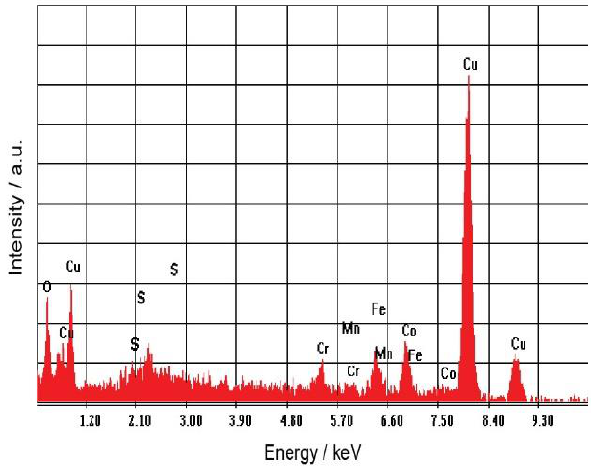
Figure 14. EDS spectra for the CoCrFeMnNi alloy, sample 2, after corrosion.